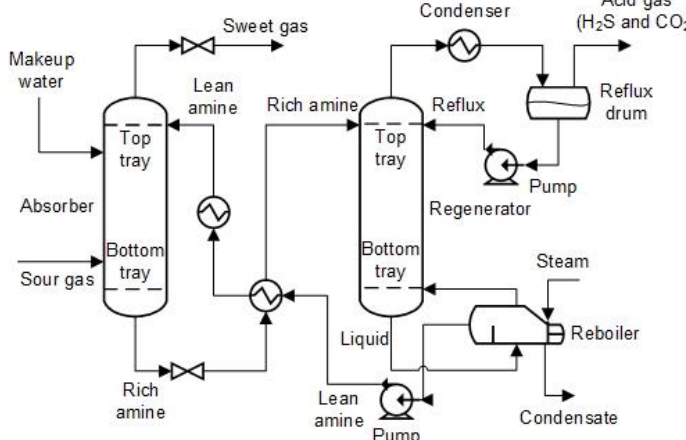
Figure 2. Typical process flow diagram of an amine-treating unit.